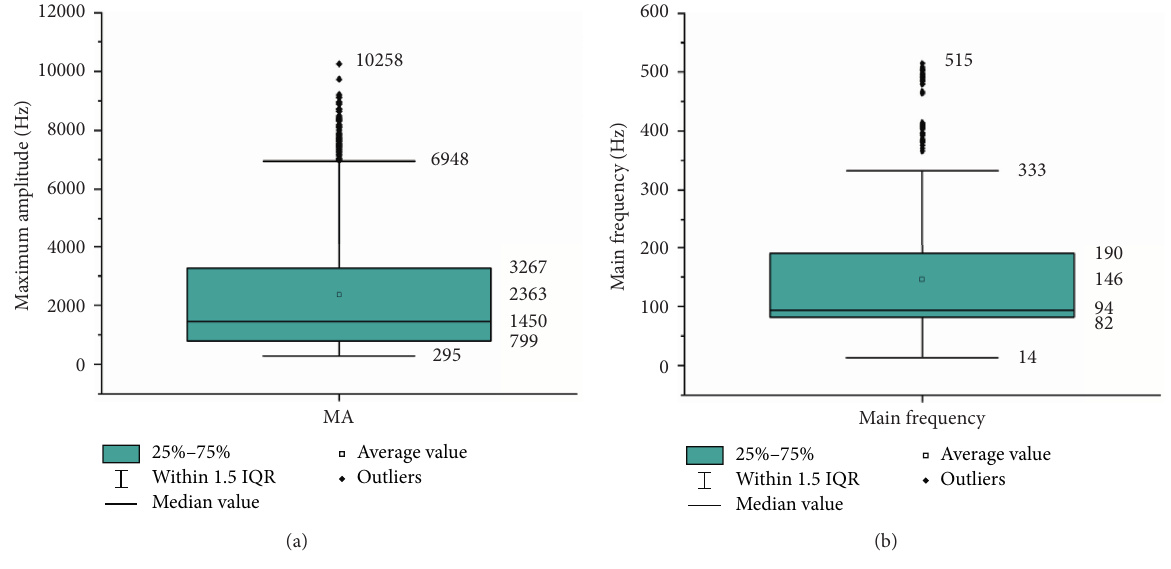
Figure 7: Box diagram of (a) MA and (b) main frequency.